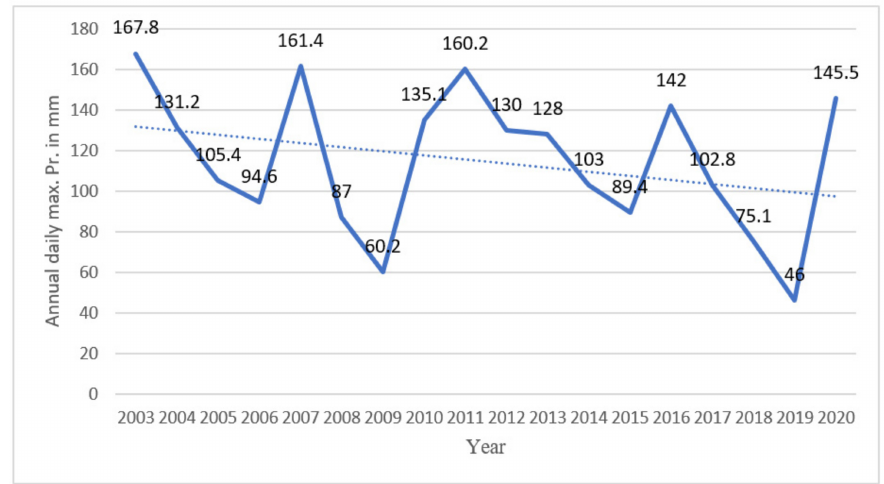
Figure A6. Observed annual daily maximum precipitation of Damauli, Tanahun.